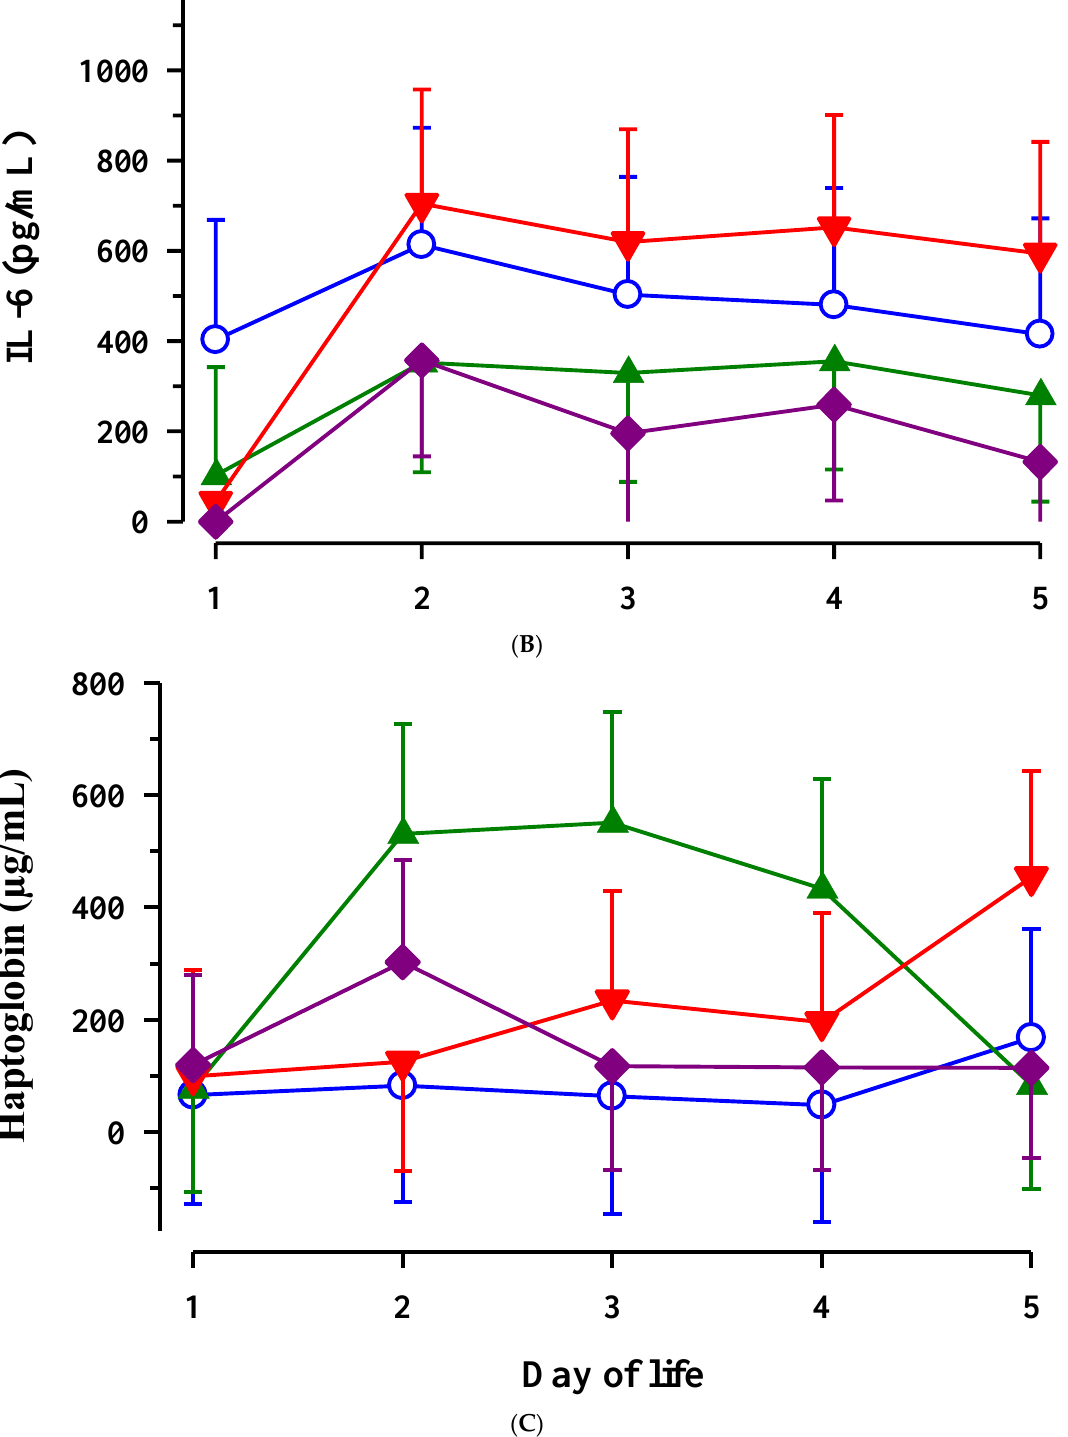
Figure 4. Plasma interleukin (IL) 1- β ( A ), IL-6 ( B ) and haptoglobin (C) concentration in calves dependent on maternal fatty acid supplementation ( ○ control, CON n = 9; ▲ EFA, essential fatty acids, n = 9; ▼ , CLA, conjugated linoleic acid, n = 9; ♦ , EFA + CLA, n = 11) and time after birth. Day 1 corresponded to the day of birth. ab Different superscripts mark significant differences between groups at similar time points ( p < 0.05). X designates significant differences between calves with maternal EFA supplementation and without maternal EFA supplementation within a time point ( p < 0.05).